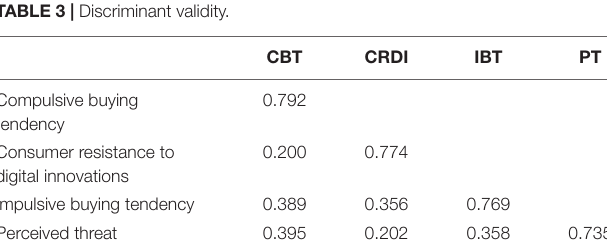
TABLE 3 | Discriminant